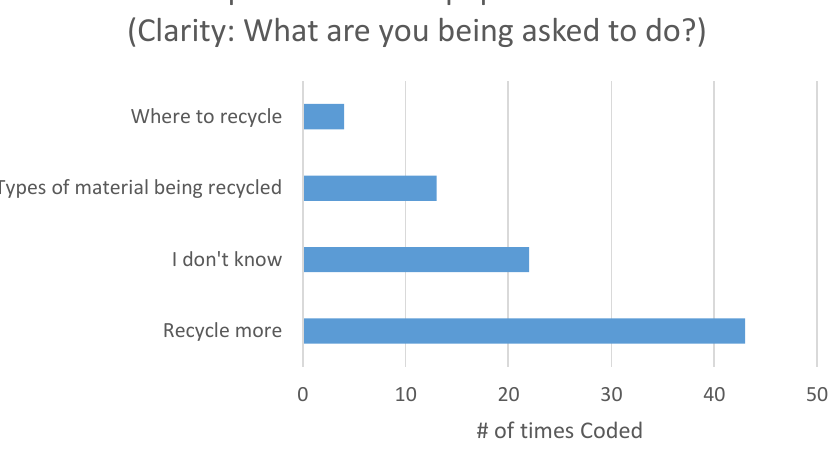
Figure 6. Coded Responses to Newspaper Advertisements (Clarity: What are you being asked to do?).